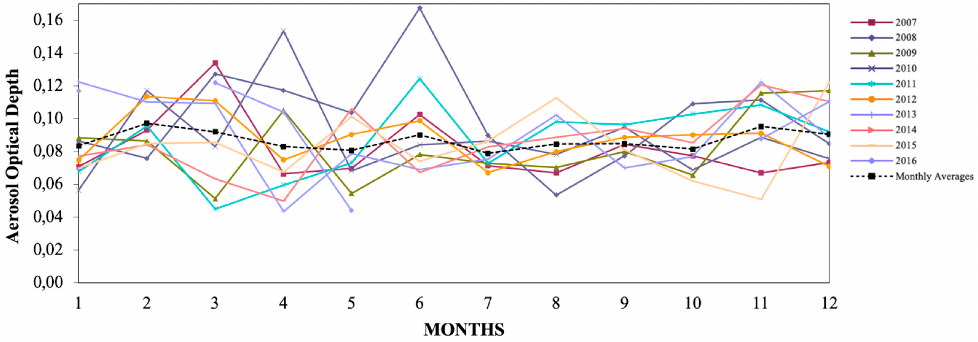
Figure 4. Monthly averaged AOD time series derived from CALIOP/CALIPSO data for the city of Natal, in the period from 2007 to 2016, each year represented by a different color. The black line represents the monthly mean of all years during the period.